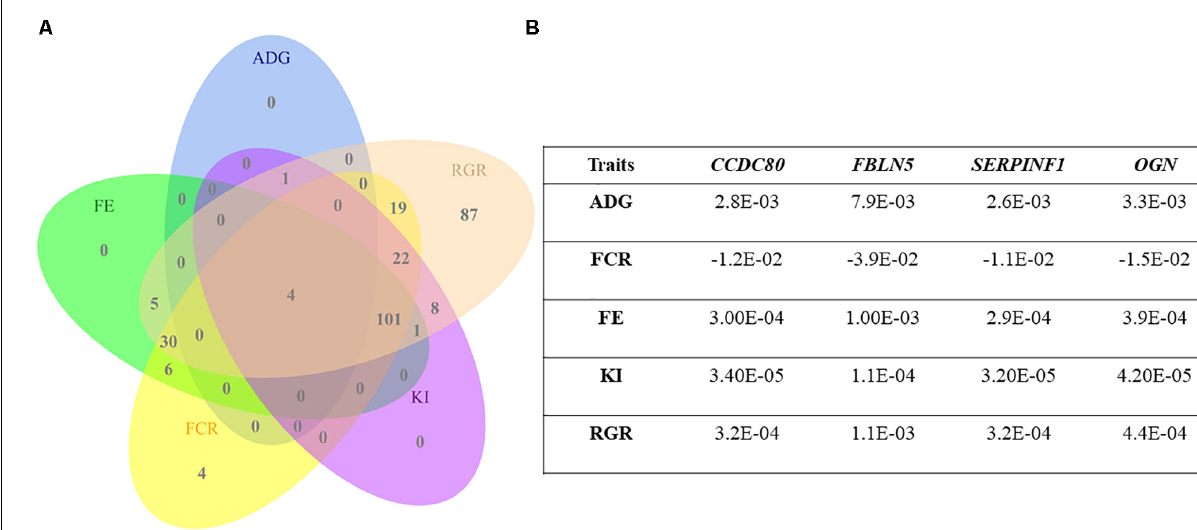
FIGURE 2 | (A) Venn diagram showing the number of hub genes whose expression levels were associated with feed efficiency-related traits ( CCDC80 , FBLN5 , SERPINF1 , and OGN ). (B) The table to the right describes the coefficients obtained from a linear model for the hub genes’ expression overlapping simultaneously